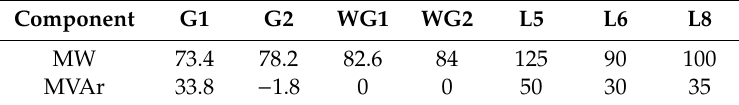
Table 1. Load flow results of the modified IEEE 9 bus system.